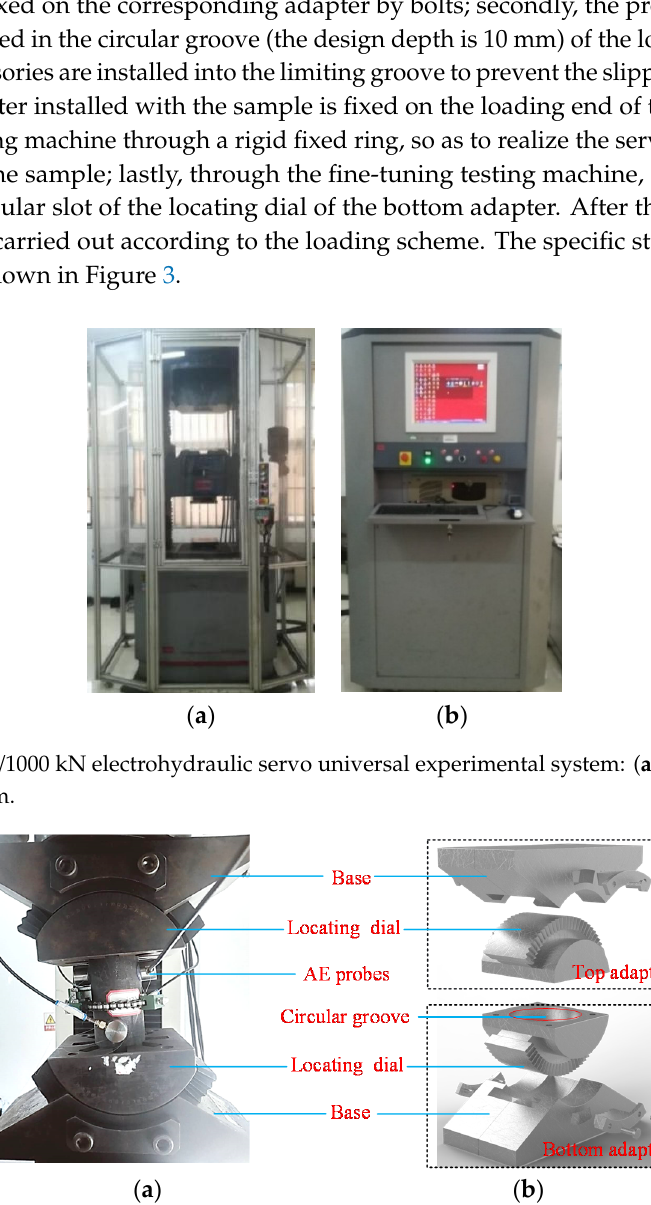
Figure 3. Structure chart of the combined compression and shear test (C-CAST) system: ( a ) The physical diagram of C-CAST system; ( b ) The 3D structure diagram of C-CAST system.